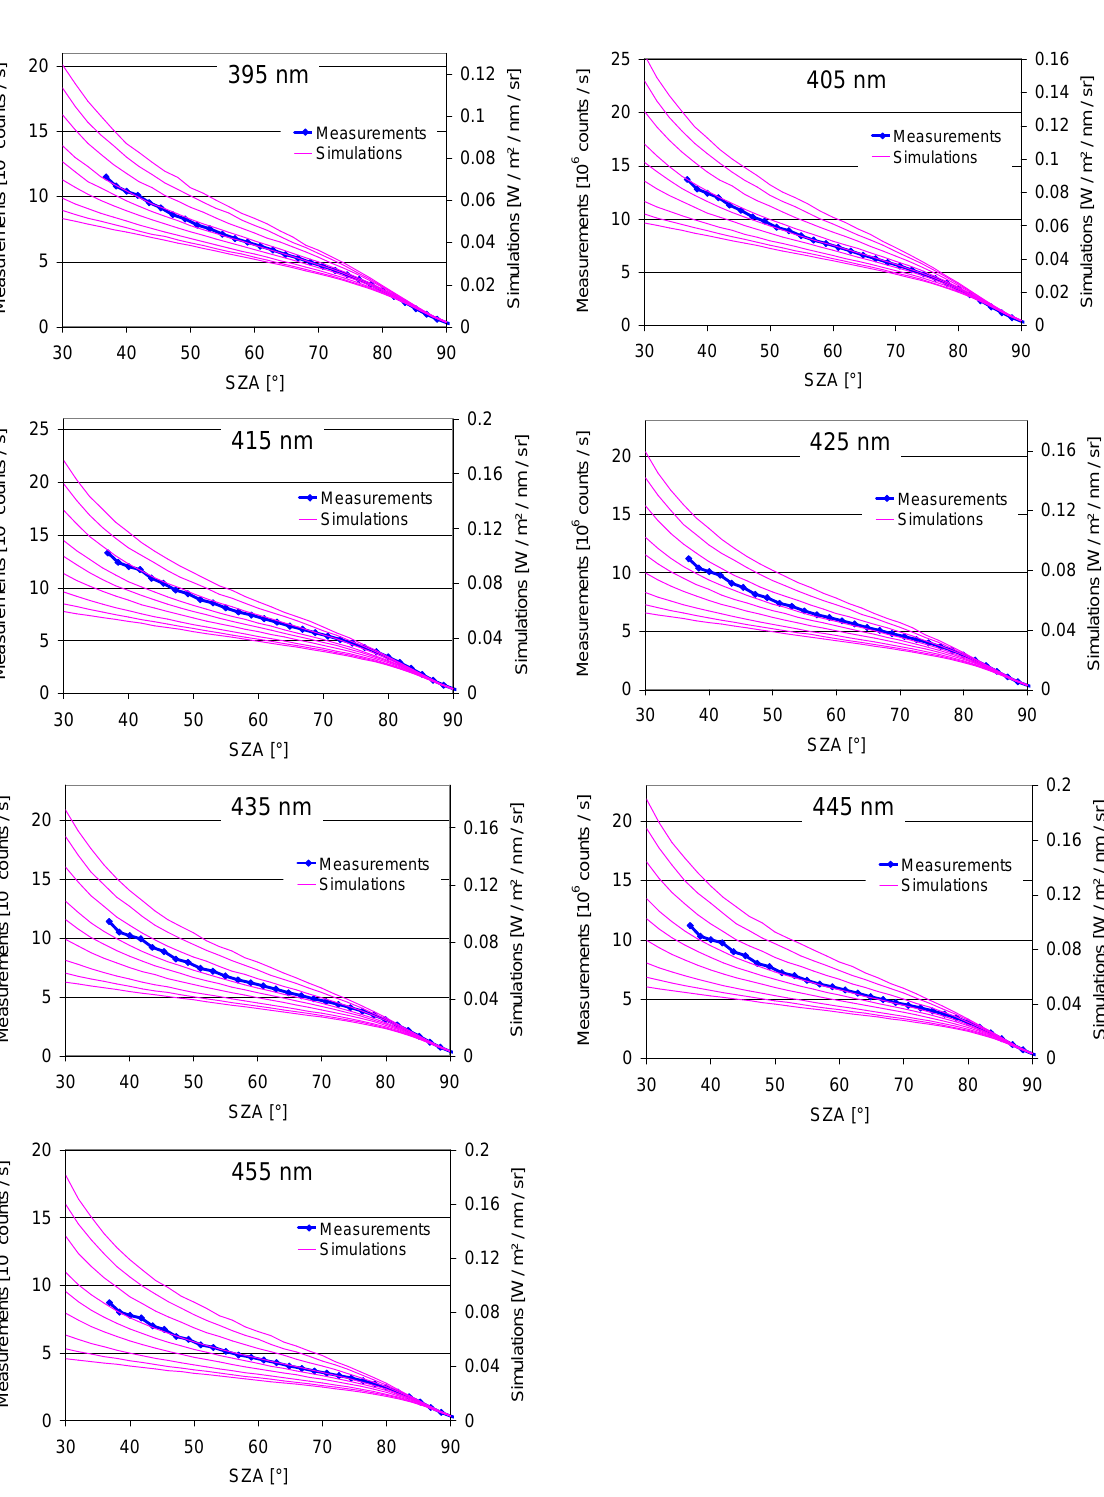
Figure A3. Comparison of measured radiances (blue, right axis) with simulated radiances (magenta lines, left axis) for all wavelengths used in our study. The lowest simulated radiances are obtained for AOD = 0, and the highest radiances for AOD = 0 .